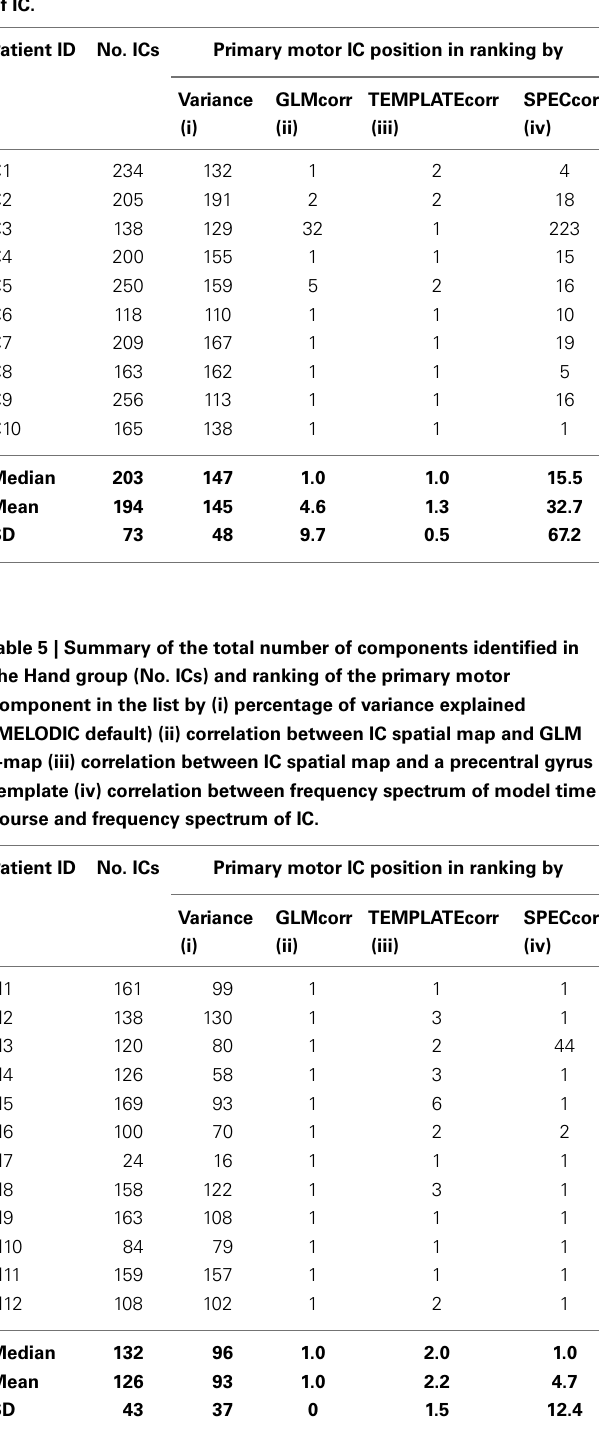
Table 4 | Summary of the total number of components identified in the Chin group (No. ICs) and ranking of the primary motor component in the list by (i) percentage of variance explained (MELODIC default) (ii) GLMcorr: the correlation between IC spatial map and GLM t-map (iii)TEMPLATEcorr: the correlation between IC spatial map and a precentral gyrus template (iv) SPECcorr: the correlation between the frequency spectra of model time courses and frequency spectra of IC.